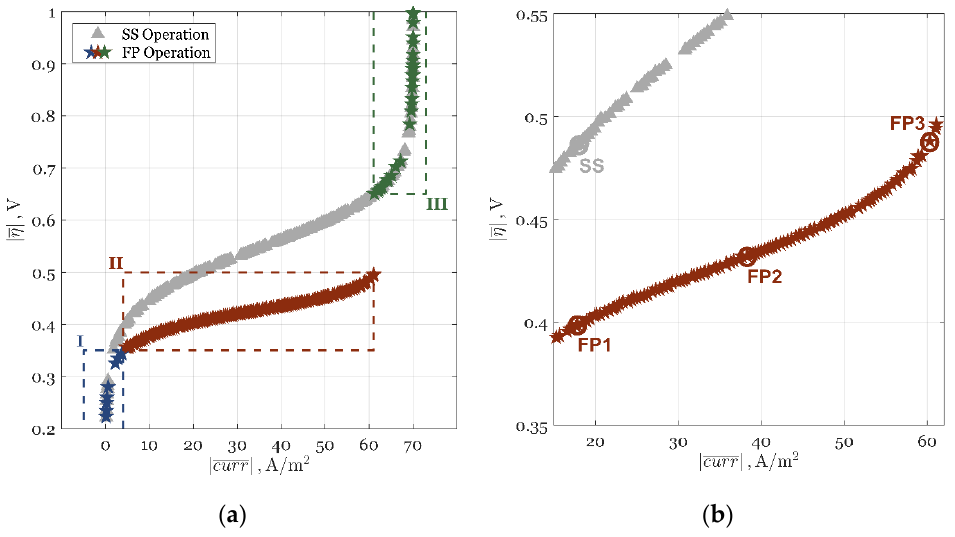
Figure 4. Absolute time-average current density (BI) and overpotential (CI) in Pareto fronts for SS (gray rectangles) and FP (colored stars) operations for the ECR example: ( a ) all obtained solutions; and ( b ) Zone II selected solution area.